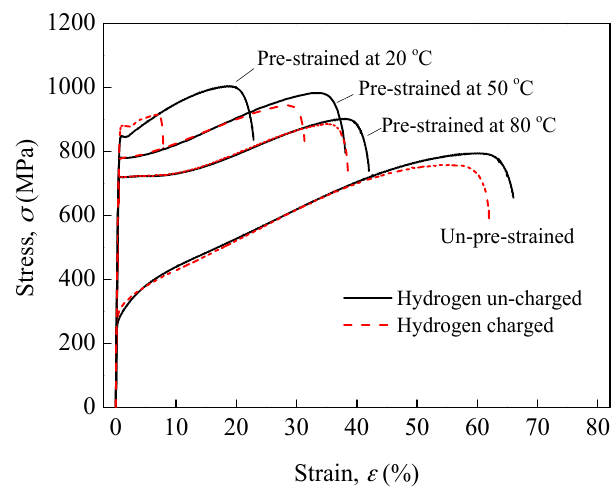
Figure 3. Nominal stress-strain curves of specimens.